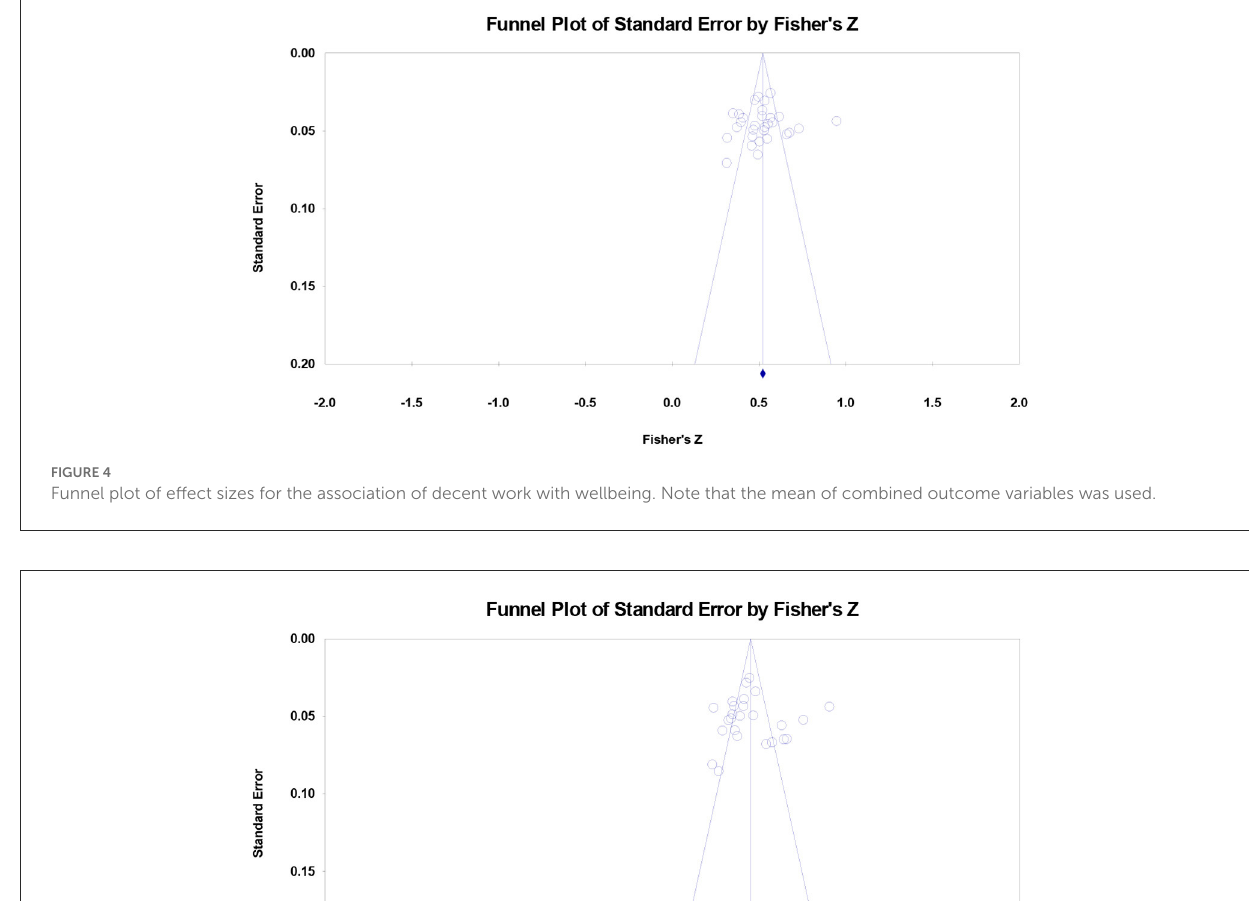
up the advocacy of decent work across the world and among different population